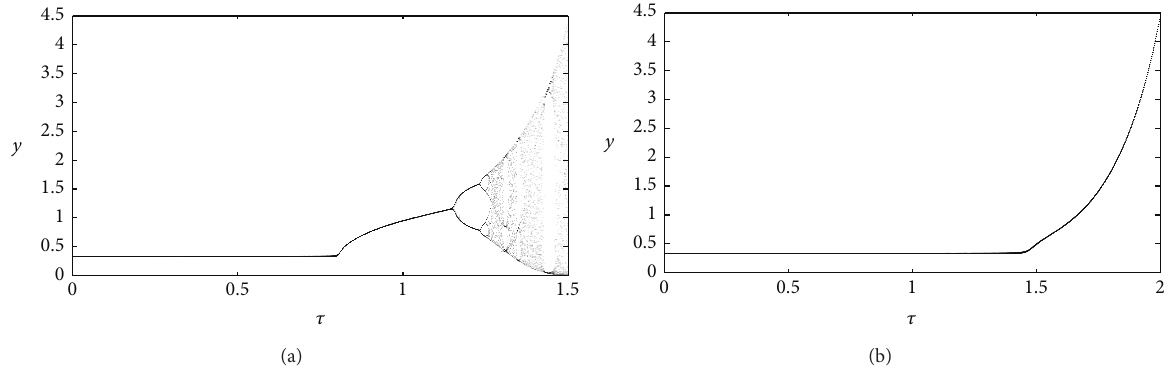
Figure 2: The bifurcation diagram of 𝑦 : (a) 𝑘 1 = 𝑘 2 = 0 ; (b) 𝑘 1 = −0.2 , 𝑘 2 = 0.5 .